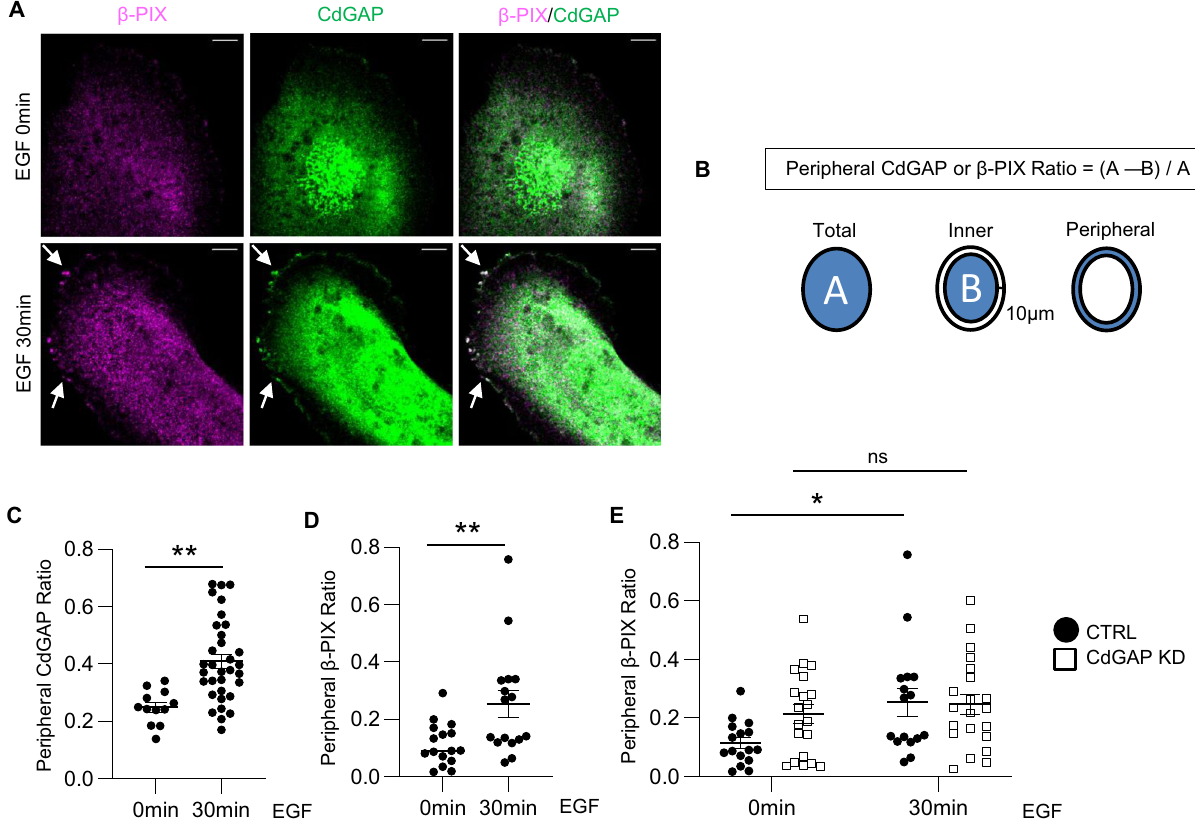
Figure 4. CdGAP and β-PIX interact and translocate to the podocyte periphery upon EGF stimulation. ( A ) Representative confocal microscopy images of the immunofluorescence staining for β-PIX (magenta) and CdGAP (green) using differentiated control (CTRL) podocytes treated with EGF (100 ng/ml) for 0 min and 30 min. Areas of colocalization at the cell periphery are demarcated by arrows. ( B ) Quantification method of the peripheral CdGAP or β-PIX ratio is outlined. ( C and D ) Quantified peripheral CdGAP ( C ) and β-PIX ( D ) ratio. ( E ) Comparison of peripheral β-PIX ratio between differentiated CdGAP KD and CTRL podocytes treated with EGF. CTRL values are the same as in ( D ) and included for comparison. n = 12 or 33 ( C ); 16 ( D ); 16 to 21 ( E ) in each group. ns, not significant. Statistically significant differences (* P < 0.05, ** P < 0.01), assessed by either the Student’s t-test ( C,D ) or ANOVA with the Tukey–Kramer test ( E ), are indicated. Bar: 10 μm ( A